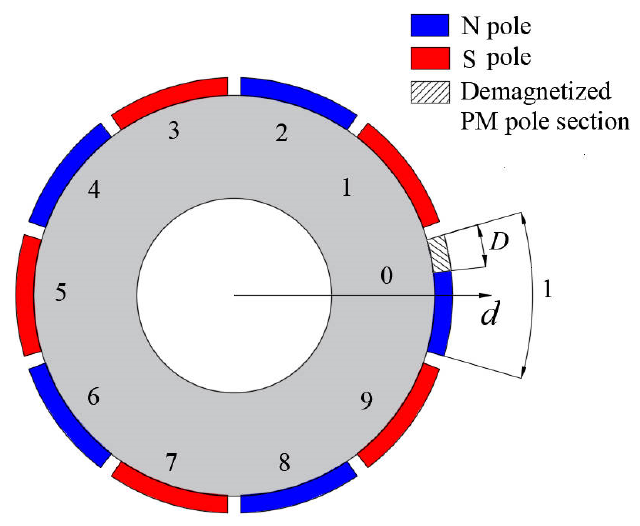
Figure 5. Model of magnets with partial demagnetization.